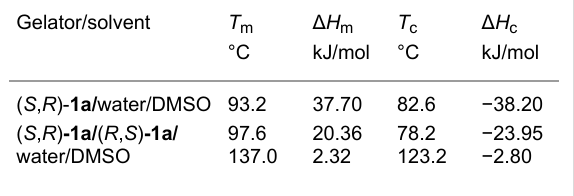
Table 4: Δ H and transition temperatures for selected retropeptide DMSO/water obtained from DSC heating and cooling